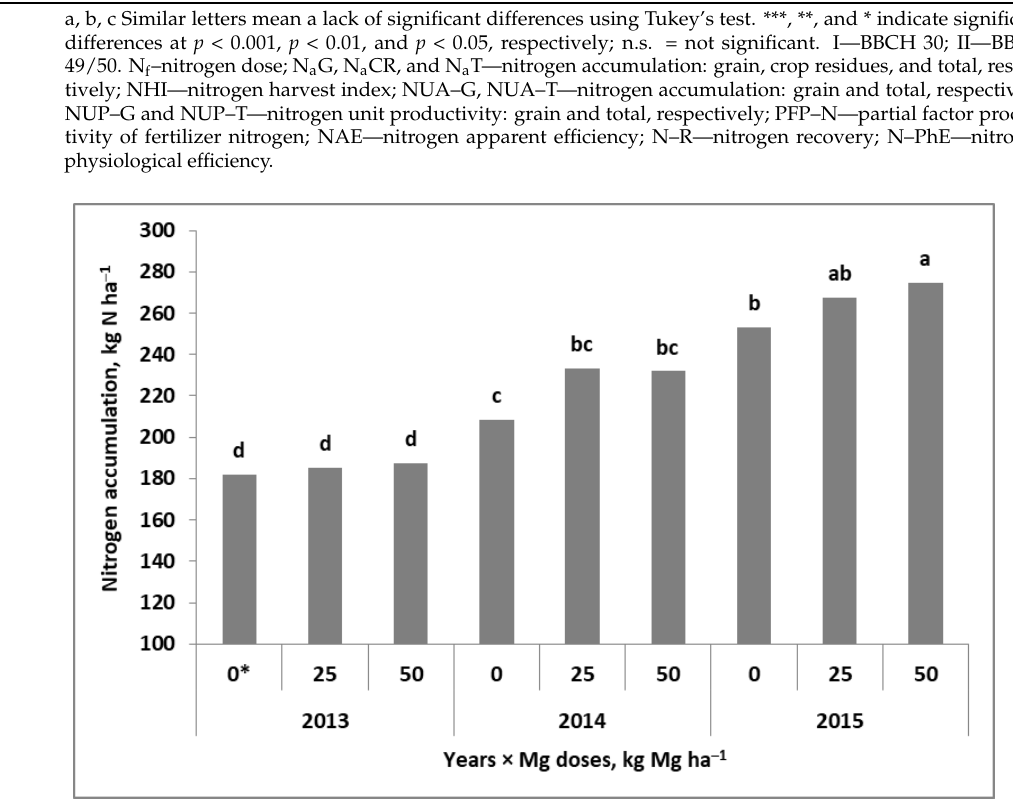
Figure 3. Effect of soil-applied magnesium to winter wheat on nitrogen accumulation in grain. a, b, c, d Similar letters mean a lack of significant differences using Tukey’s test. Mgs—soil Mg fertilization system. * Doses of applied Mg, kg ha ‒1 .